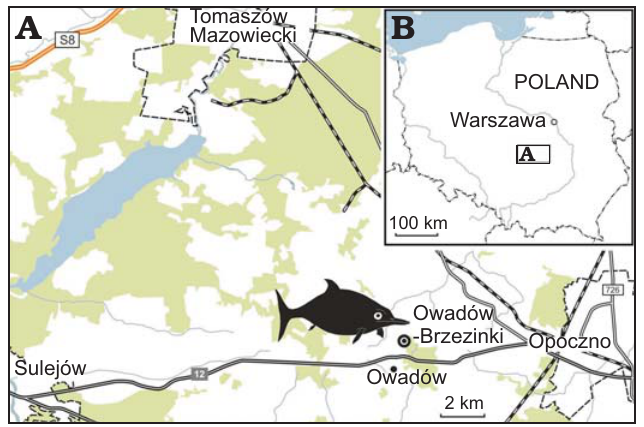
Fig. 1. General map of Poland with the location of the studied area ( B ). Location of the Owadów-Brzezinki Quarry ( A